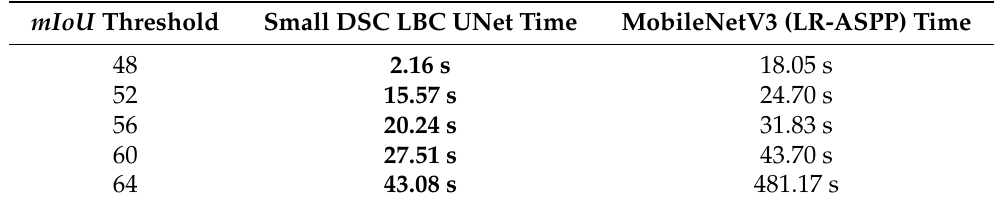
Table 4. Time in seconds for Small DSC LBC UNet and MobineNetV3 (LR-ASPP) to reach various mIoU thresholds on an AMD Ryzen 5 2600 Six-Core